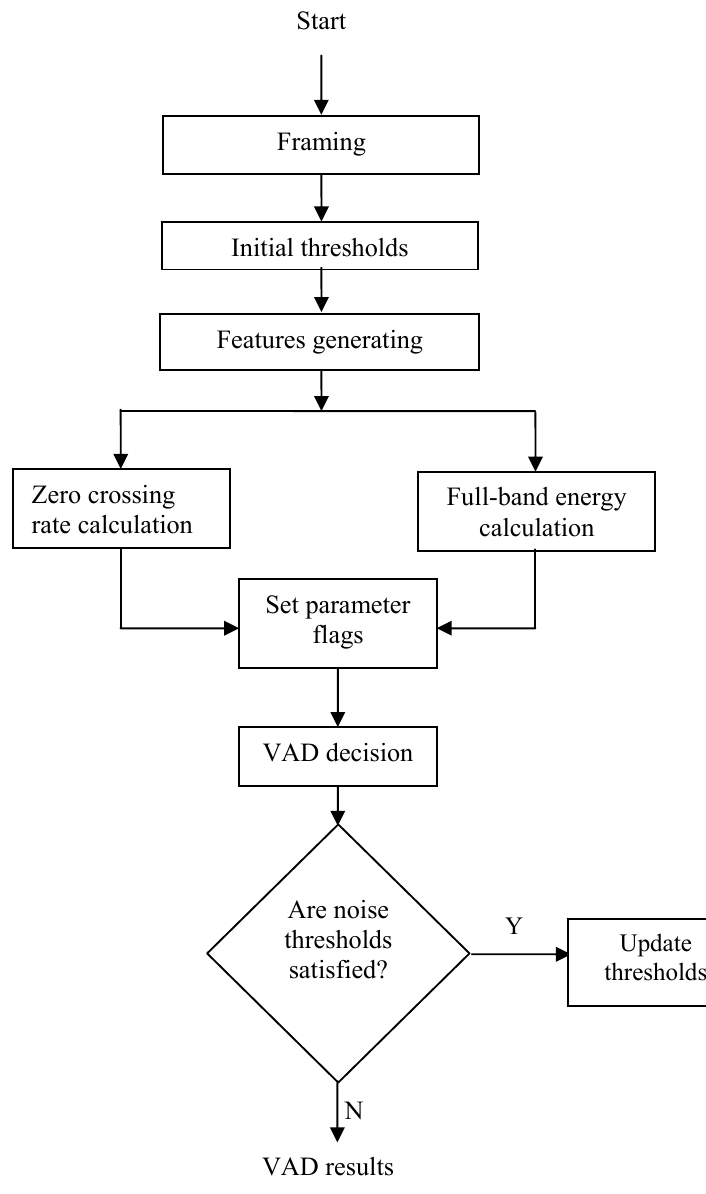
Figure 3 . Flow chart of the VAD algorithm using background noise